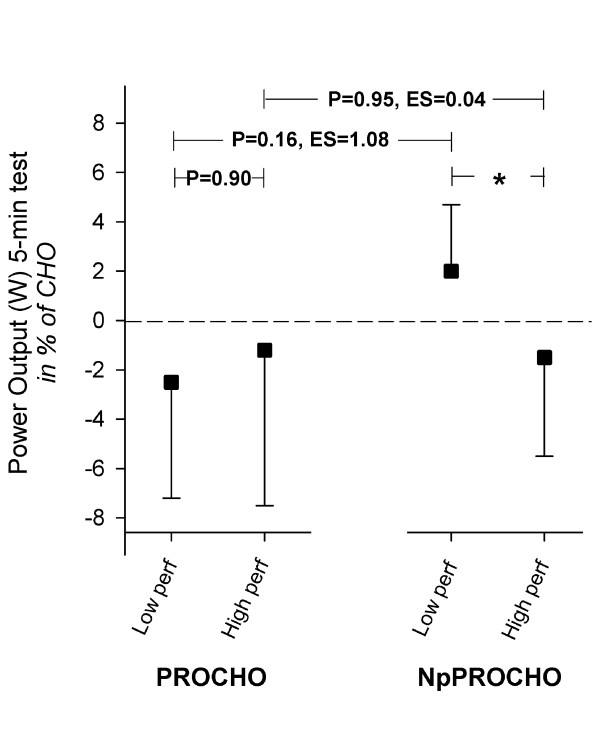
The effect of ingesting A) protein + carbohydrate (PROCHO) or B) Nutripeptin™ + protein + carbohydrate (NpPROCHO) on performance in a 5-min mean-power test following 120 min submaximal cycling at 50% of Wmax in the six lesser performing cyclists (lesser perf) compared to the six superior performing cyclists (superior perf). Power-output values for the two beverages were referenced to values obtained for the carbohydrate (CHO) beverage, which was defined as baseline performance. Values on the Y-axis thus depicts the difference in performance between PROCHO and CHO ingestion and NpPROCHO and CHO ingestion, respectively, and is denoted as percentage. * = P < 0.05. N = 12.